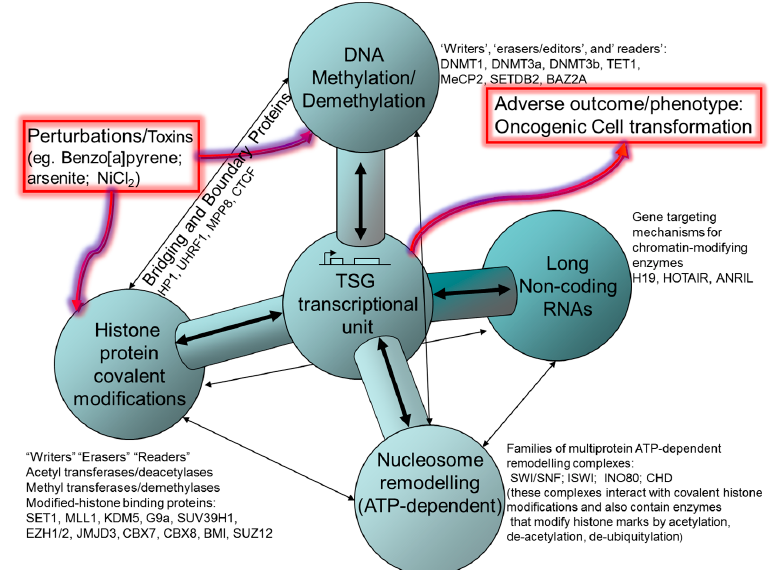
Figure 4. An epigenetic framework for pathways regulating persistent tumour suppressor gene transcription effects related to oncogenic transformation. The four main processes in the epigenetic framework acting upon the nucleosomes and DNA template of a gene transcription unit (larger arrows) are driven by multi-subunit protein complexes that act (1) to enzymatically modify DNA or (2) modify histone proteins, (3) remodel chromatin structure by moving nucleosomes along DNA and exchanging specific histones into and out of assembled chromatin, and (4) act via long non-coding RNA